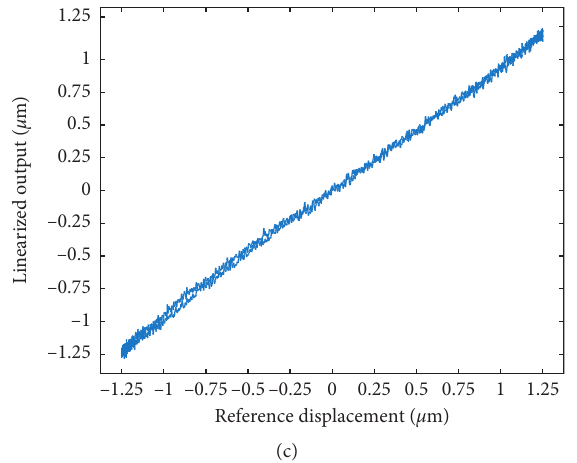
Figure 12: The feedforward compensation results in the X -direction. (a) The hysteresis inverse model in the X -direction. (b) The output hysteresis curve. (c) The linearized output.